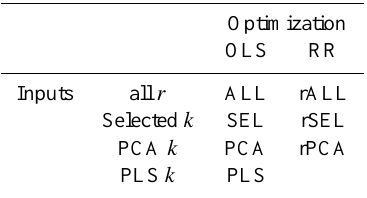
Table 2. Summary of regression models: OLS – ordinary least squares; RR – Ridge